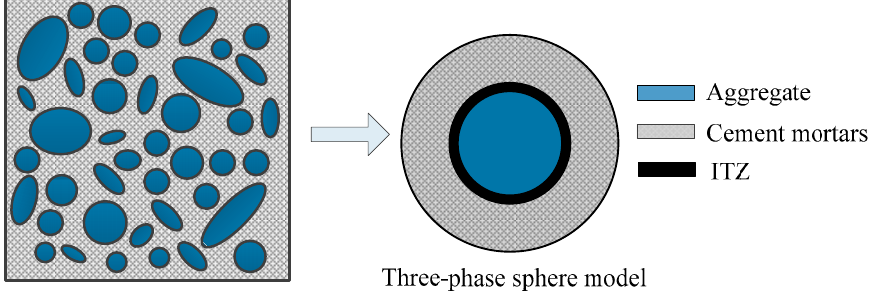
Figure 3. Three-phase sphere model of